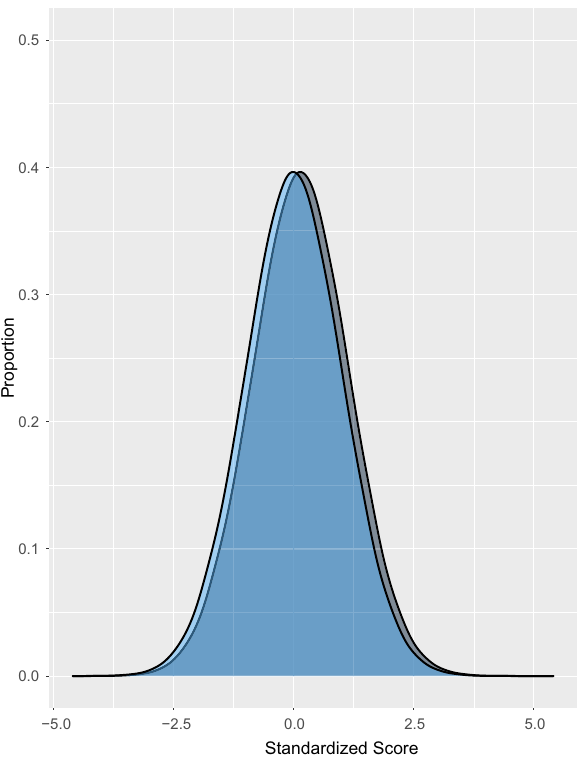
Figure 3. Illustration of the magnitude of change for SMD = 0.15 assuming a normal distribution. The hypothetical blue distribution represents pre-COVID-19 scores, and the grey distribution represents post- COVID-19 scores with a mean symptom increase of SMD =